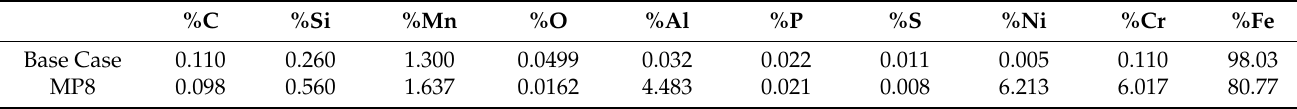
Table 3. Bulk chemical composition of weld metals (mass%)